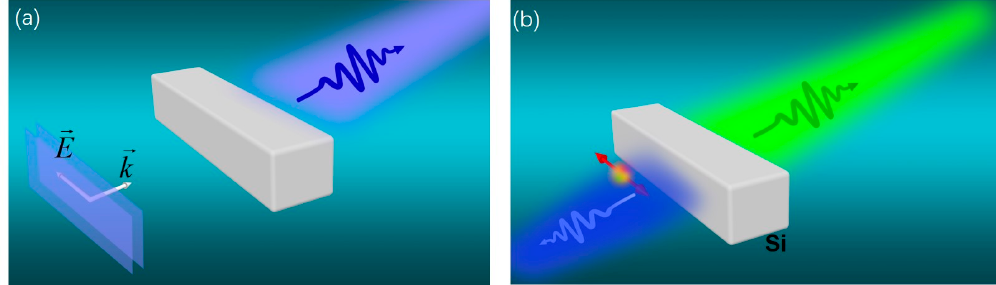
Figure 1. Schematic illusions of ( a ) unidirectional scattering of Si nanoblock under plane wave excitations as well as ( b ) switchable directive emission excited by a localized emitter. ( a ) The Si nanoblock was excited by a plane wave with polarization along the long axis of the nanoblock. When the Kerker condition is satisfied, a destructively interference in the backward direction occurs, leading to unidirectional forward scattering. ( b ) Sketch of a dipole emitter (denoted as the red arrow) in the vicinity of a silicon nanoblock in free space, showing forward and backward emission at di ff erent